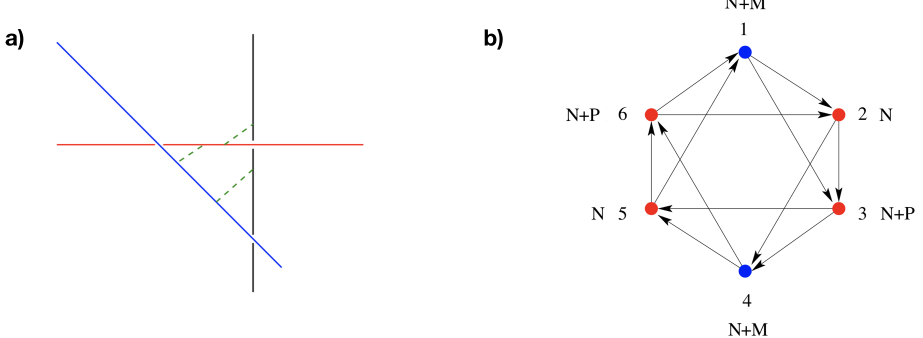
Figure 3 . a) Web diagram of the complex cone over dP 3 splitting into three sub-webs. b) Rank assignment (fractional branes) that trigger those complex deformations.